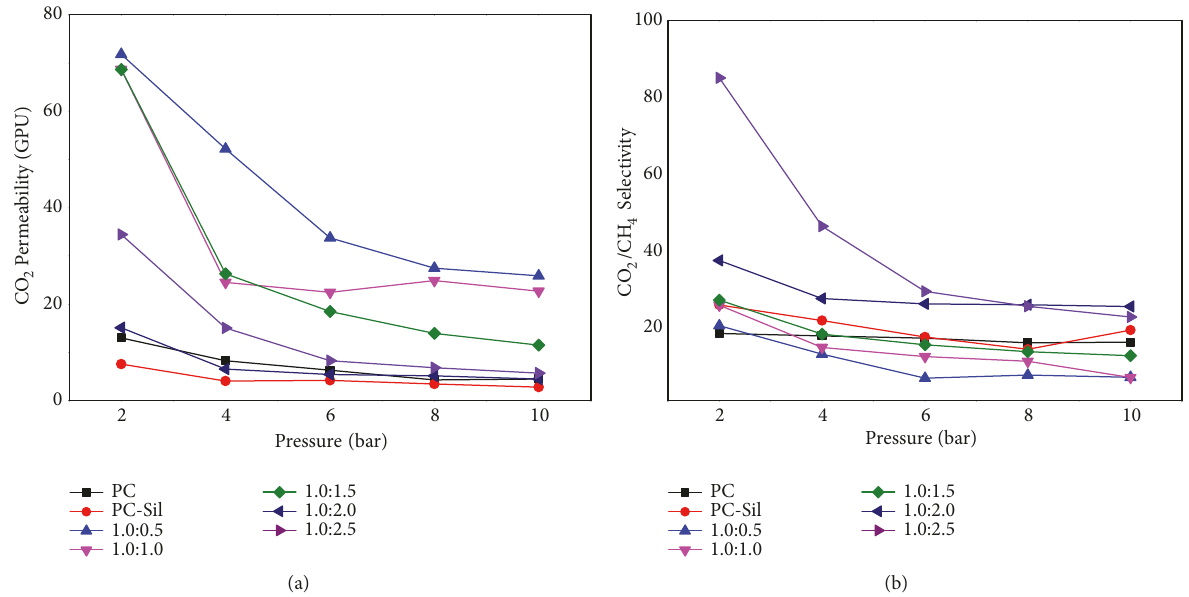
Figure 7: Effect of feed pressures on (a) CO 2 permeance, and (b) CO 2 /CH 4 selectivity of prepared membranes.